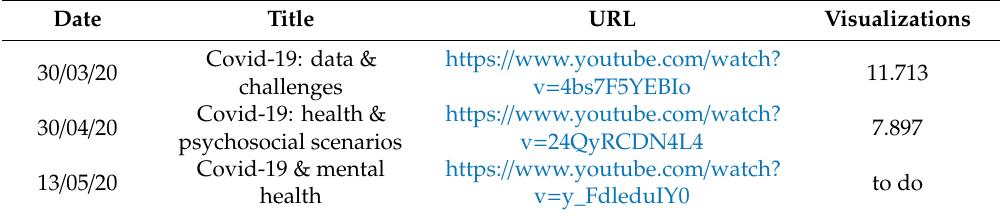
Table 2. List of online Science Caf é s organized by “FormaScienza”, Roma.